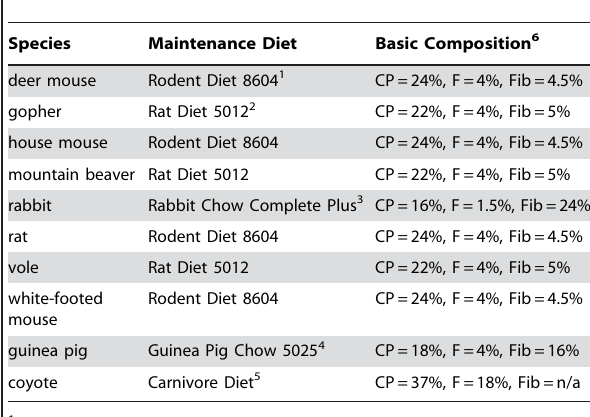
Table 3. Maintenance diets provided ad libitum to subjects.